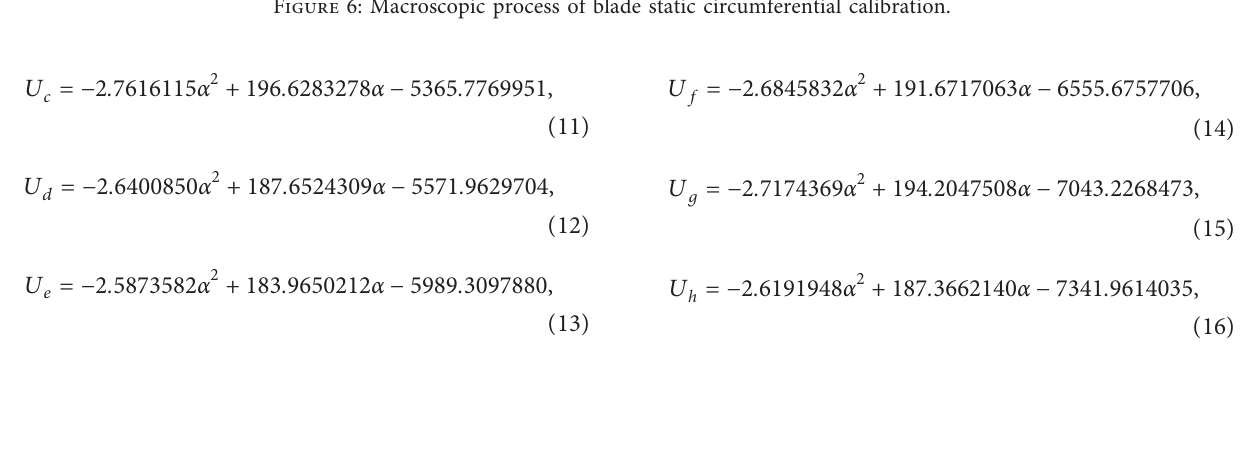
Figure 6: Macroscopic process of blade static circumferential calibration.